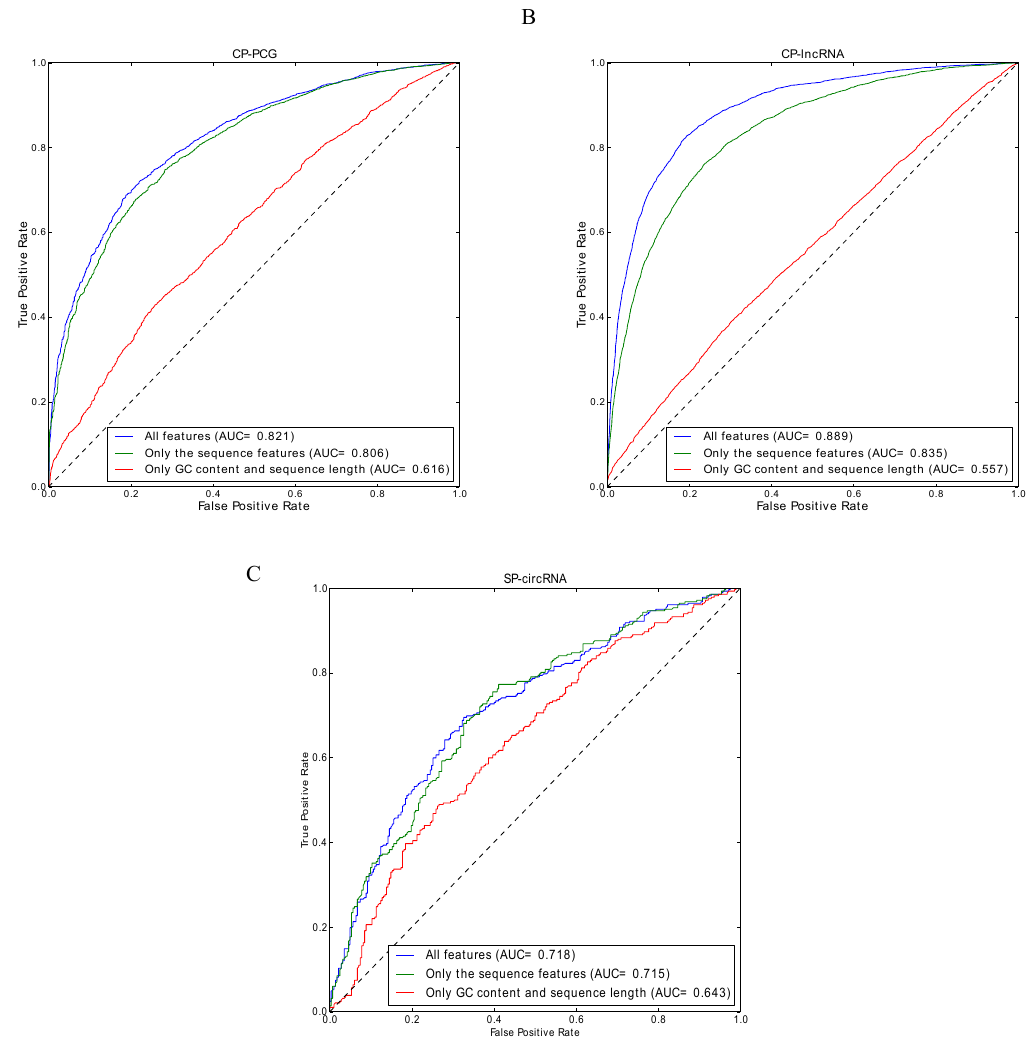
Figure 3. ROC curves for: ( A ) the PCG circRNA model (CP-PCG); ( B ) the lncRNA circRNA model (CP-lncRNA); and ( C ) stem cell circRNA model (SP-circRNA). In these three instances, the ROC curve using all 178 features indicated in Table 2 is compared to models using “only the GC content and sequence length” and “only the sequence